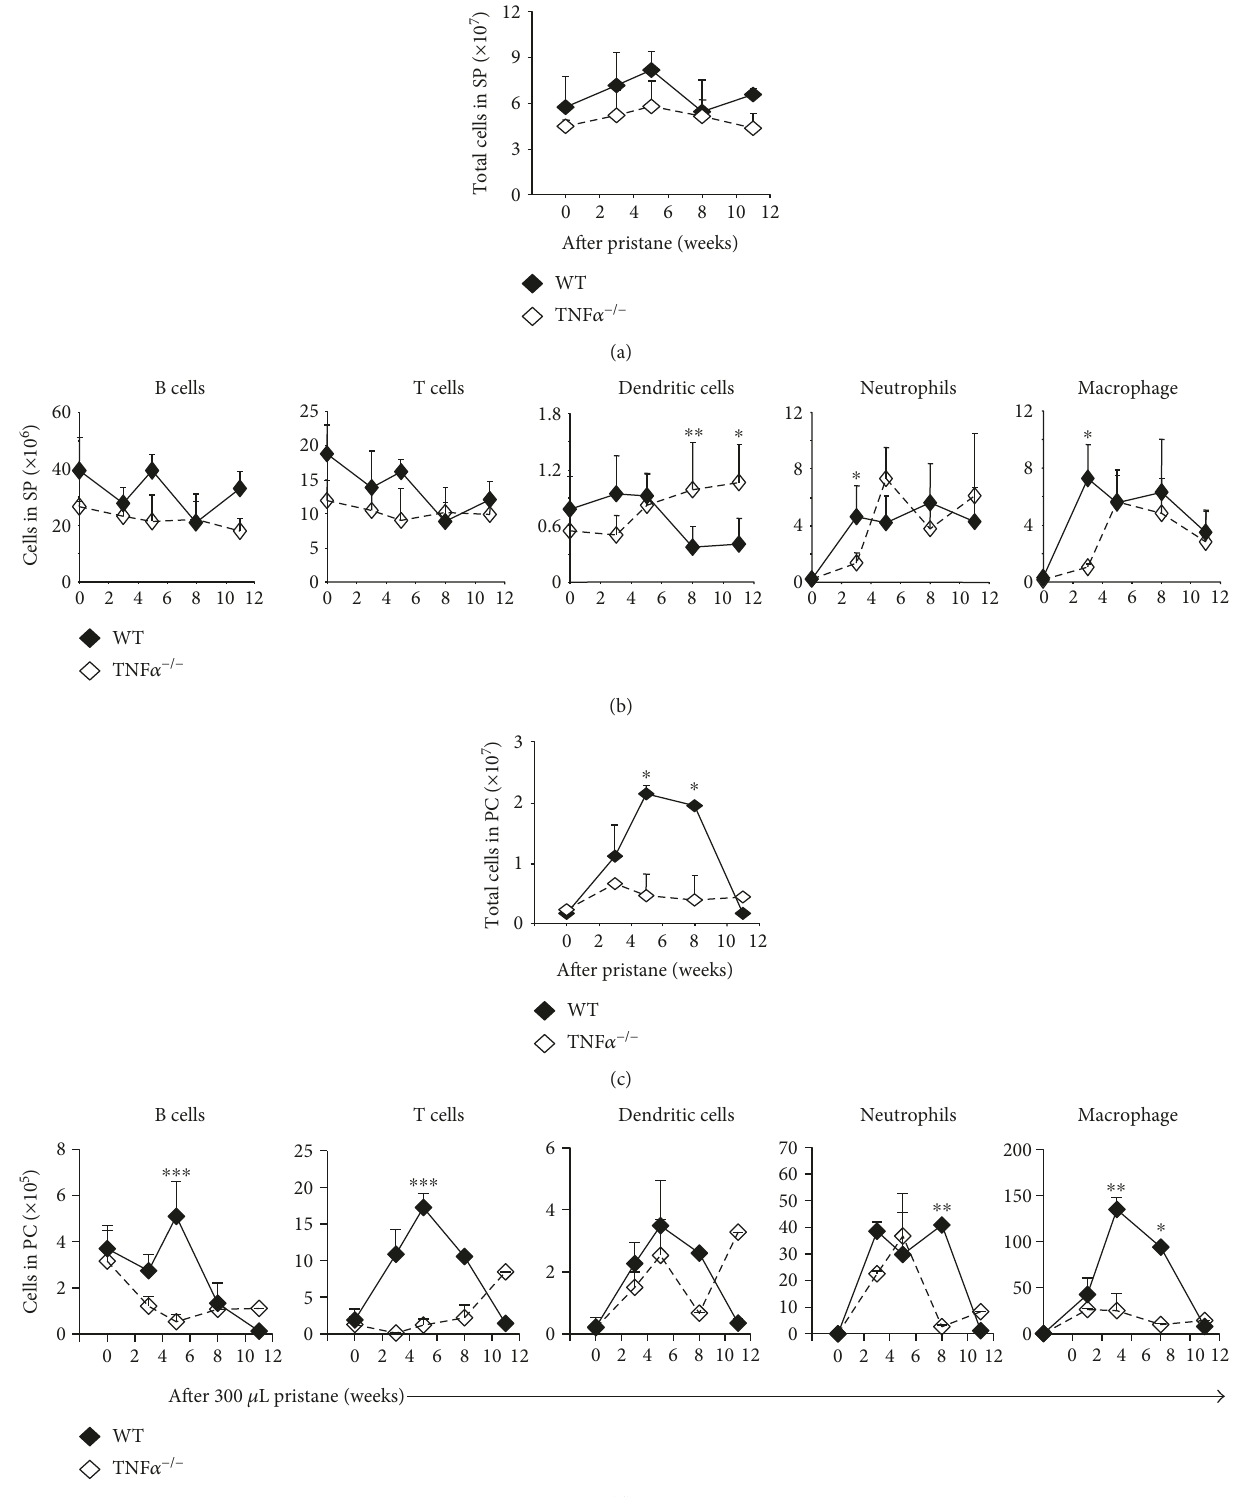
Figure 4: Lack of TNF α delayed the recruitment of splenic neutrophils and macrophages in response to pristane treatment. (a, b) TNF α − / − mice and WT mice were injected with 300 μ L (8.3 × 10 − 4 mol) of pristane and were then sacri fi ced at the indicated time points. The total number of cells and the number of each cell type were calculated. (c, d) The total number of cells or the number of each cell type in the PC was also analyzed. The di ff erence between WT and TNF α − / − mice is shown. Data represent two independent experiments. ∗ p < 0 05 , ∗∗ p < 0 01 , and ∗∗∗ p < 0 001